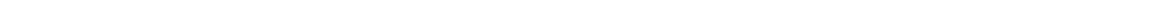
Fig. 5 Loss of miR-31 results in compromised mammary tumor progression and reduces number of cancer stem cells. a Representative whole-mount staining of MMTV - PyVT ( PyVT ) and MMTV - PyVT/miR-31KO ( PyVT/KO ) mammary glands at 12 and 16 weeks of age. Quanti fi cation of PyVT tumor areas at 12 weeks ( PyVT : n = 12; PyVT/KO : n = 9) and 16 weeks ( PyVT : n = 12; PyVT/KO : n = 6) of age. Scale bar, 2.5 mm. b Gross images of mammary tumors from PyVT and PyVT/KO mice at 20 weeks of age. Quanti fi cation of mammary tumor volume from PyVT ( n = 13) and PyVT/KO ( n = 9) mice at 20 weeks of age. c H&E of PyVT and PyVT/KO tumors at 12 weeks of age. Higher magni fi cation images indicated by dashed boxes shown in the lower panels. Arrowheads, nuclei with diverse shape. Scale bar, top panels, 50 μ m; lower panels, 16 μ m. d Immunohistochemistry for Ki67 and quanti fi cation of Ki67 + cells in PyVT and PyVT/KO mammary tumors at 12 weeks of age. Scale bar, 25 μ m. e Immunostaining for Gata-3 and ER α in PyVT and PyVT/KO mammary tumors at 12 weeks of age. Scale bar, 25 μ m. f Western blotting for Gata-3, ER α , K8 and K14 in PyVT and PyVT/KO tumors at 12 weeks of age. g Immuno fl uorescence for K14 and K8 at the leading edges of tumors and mammary ducts from PyVT and PyVT/KO mice. Scale bar, 25 μ m. h qRT-PCR for miR-31 in CD24 + CD90 - and CD24 + CD90 + cells from PyVT tumors. n = 3 biological replicates. i Pro fi les of CD90-PE and CD24-PE-Cy7 in cell suspensions from PyVT and PyVT/KO tumors. Arrows, CD24 + CD90 + cells. Quanti fi cation of CD24 + CD90 + cells in PyVT ( n = 4) and PyVT/KO ( n = 4) tumors. j Limiting dilution transplanted assay showing tumor-initiating cell frequencies (with con fi dence intervals) χ 2 -values and associated probabilities. P = 0.0256. Data represented as mean